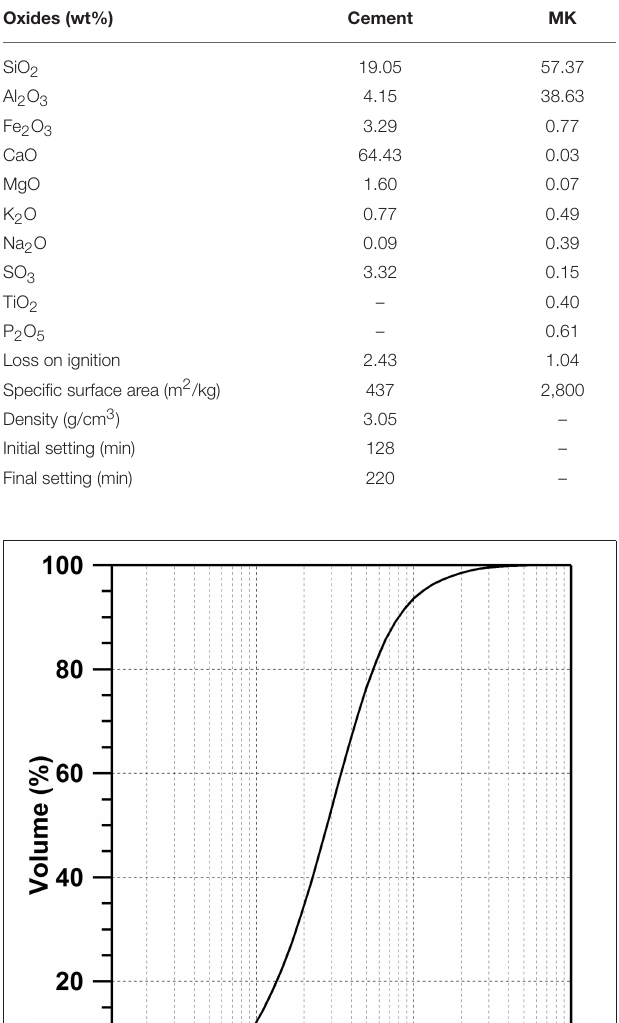
TABLE 1 | Chemical composition and physical properties of cement and metakaolin used in this study.